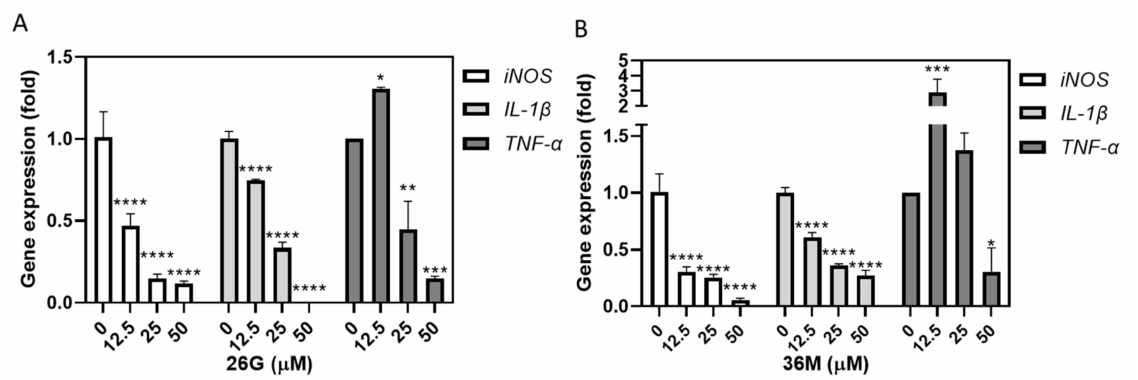
Figure 6. Both 26G and 36M suppressed pro-inflammatory gene expression in RAW264.7 cells. ( A ) The pro-inflammatory gene expression in RAW264.7 cells after 12.5–50 µ M 26G treatment, and ( B ) 12.5–50 µ M 26G treatment for 24 h. P-values were calculated by using the one-way ANOVA. * p < 0.05, ** p < 0.01, *** p < 0.001, and **** p <